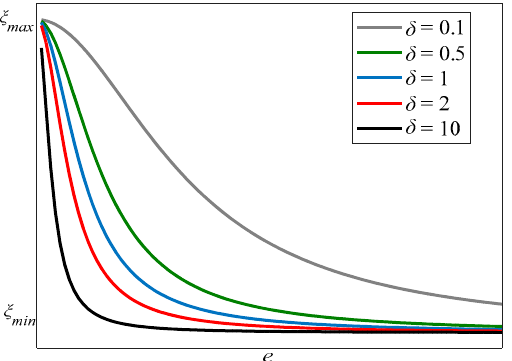
Figure 2. Damping ratio changing along with error and sensitivity factor.